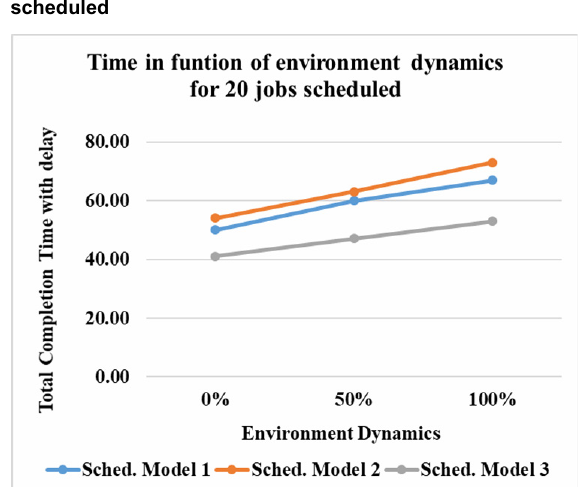
Figure 4. Simulation results of 3 Scheduling Models over the environment scenario 1 (variation of amplitude 0%)